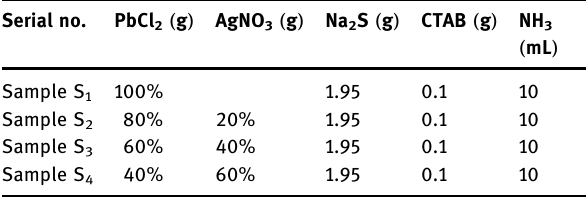
Table 1: Samples of PbS ( in 50 mL ) , AgNO 3 ( in 50 mL ) , and Na 2 S ( in 50 mL ) prepared with di ff erent ratios Serial no.